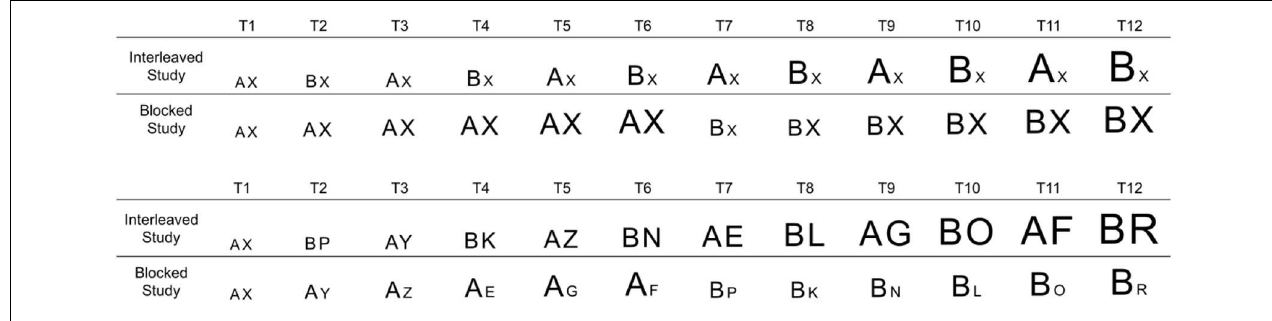
The top panel represents categorization of two low discriminability categories (both categories share the X feature), while the bottom panel represents categorization of two high discriminability categories in that the two categories do not share any feature between them. The size of each letter reflects the attention paid to